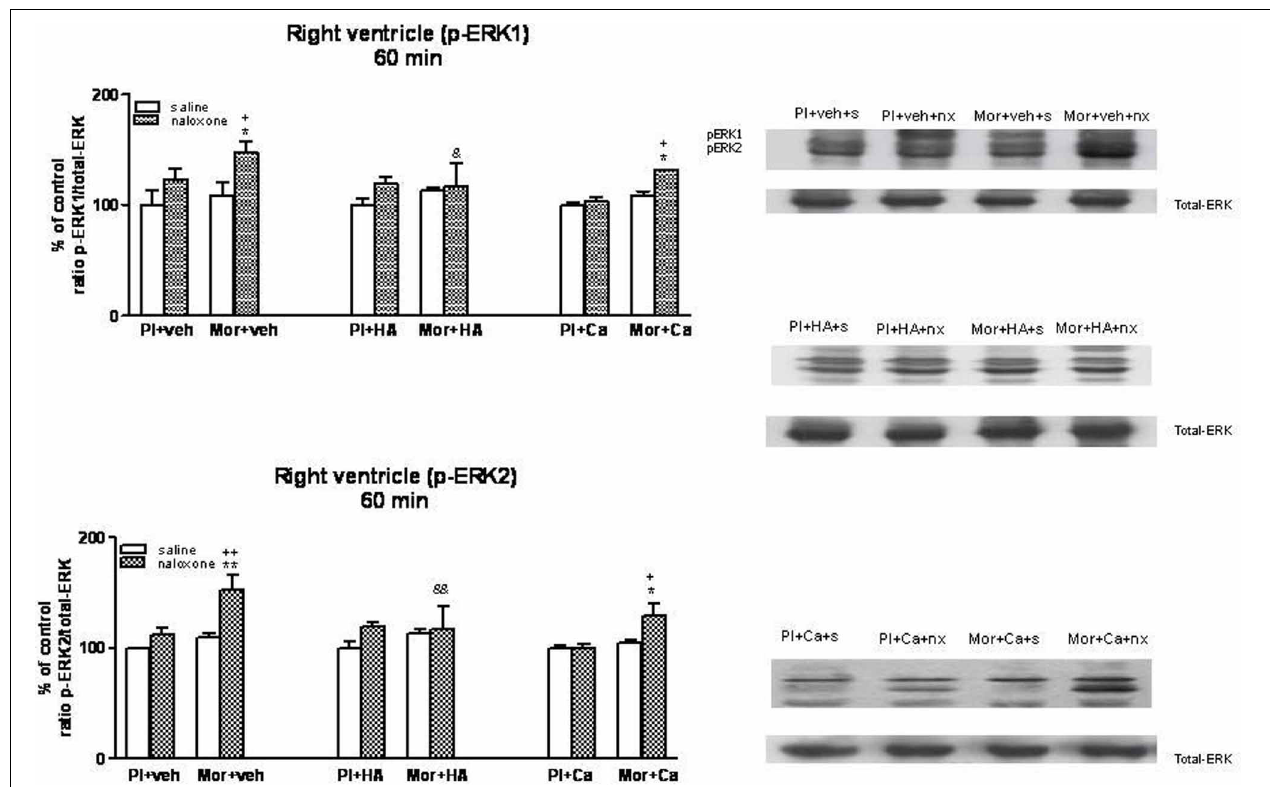
FIGURE 3 | Western blotting analysis of phospho (p)-ERK1 and phospho (p)-ERK2 immunoreactivity levels in the right ventricle 60min after saline (s) or naloxone (nx) administration to placebo (Pl)- or morphine (Mor)-treated rats receiving vehicle (veh), HA1004 (HA) or calphostin (Ca). The immunoreactivity corresponding to ERK1 or ERK2 is expressed as a percentage respect to the control group (Pl + veh + saline; defined as 100% value). Data are the